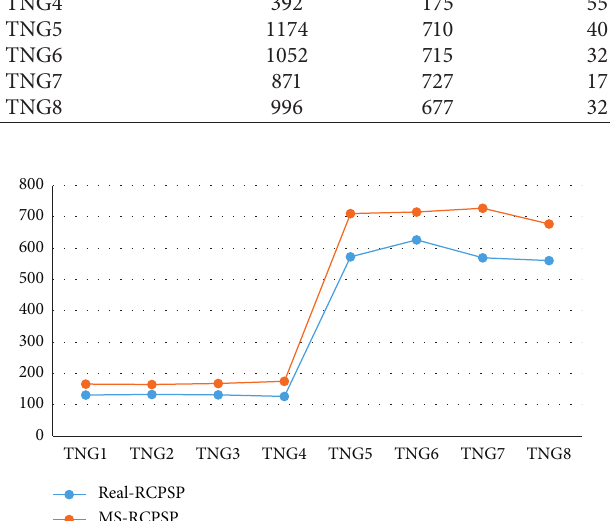
Figure 6: R-CSM to solve MS-RCPSP and